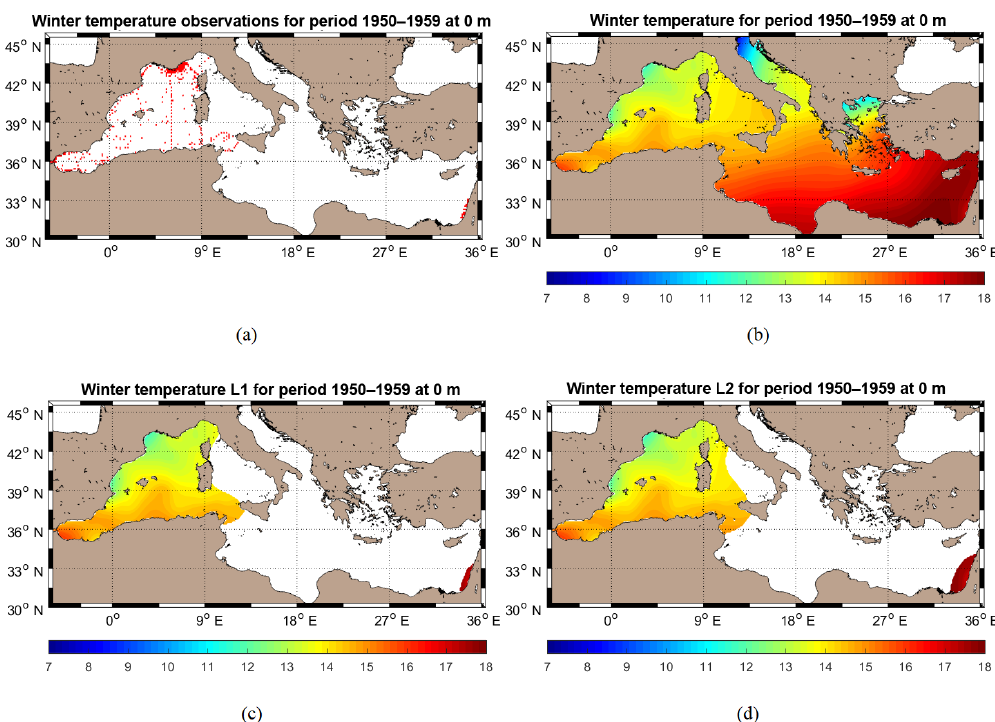
Figure 4. Example of observations distribution (a) and corresponding fields distributions depending on relative error threshold values, (b) an unmasked field, (c) a masked field with relative error threshold = 0.3, and (d) a masked field with relative error threshold =